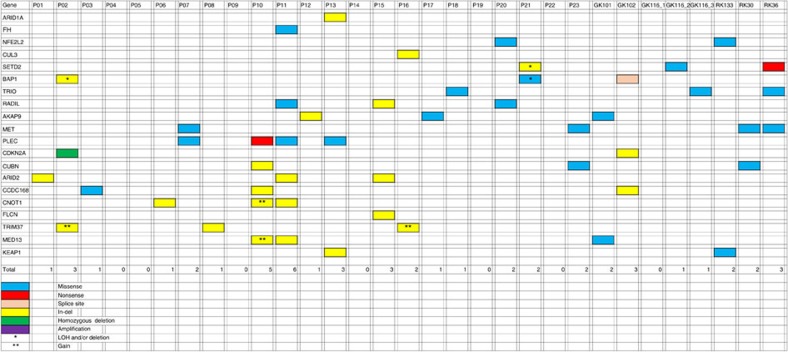
Distribution of selected somatic SNVs with predicted pathogenic effects and indels across cancers.The germline FH mutation, the somatic CDKN2A deletion and the large deletion with break point within ARID1A are also shown for completeness. Note that copy number and LOH data are not shown for cancers GK101, GK102, GK116_1, GK116_2, GK116_3, RK133, RK30 and RK36 since these lack SNP array data.